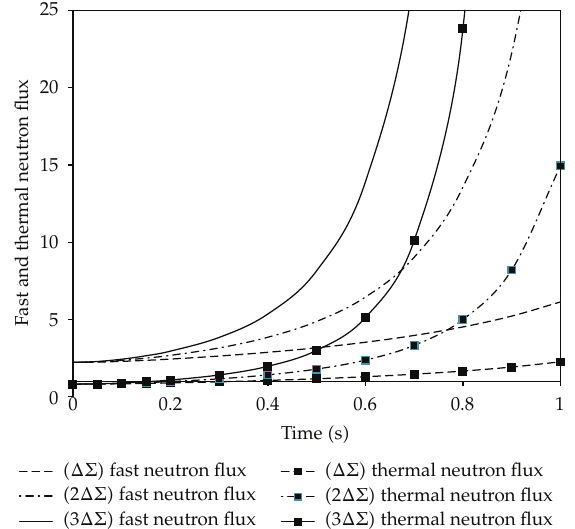
Figure 3: Fast and thermal neutron flux at a positive ramp